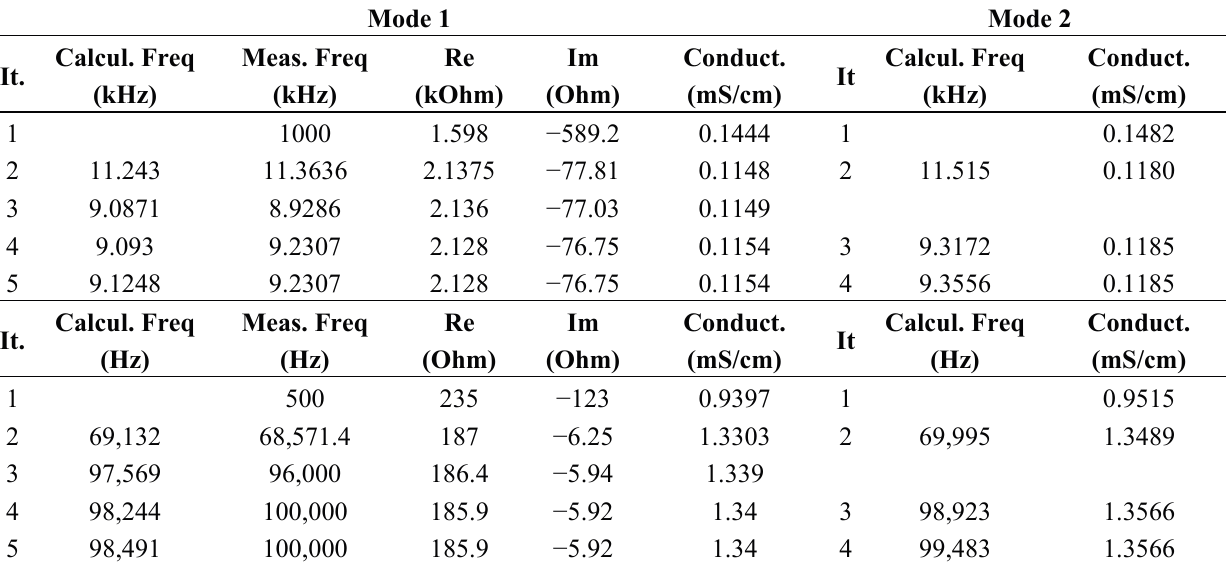
Table 1. Iterative steps provided by Agilent 4284A for two